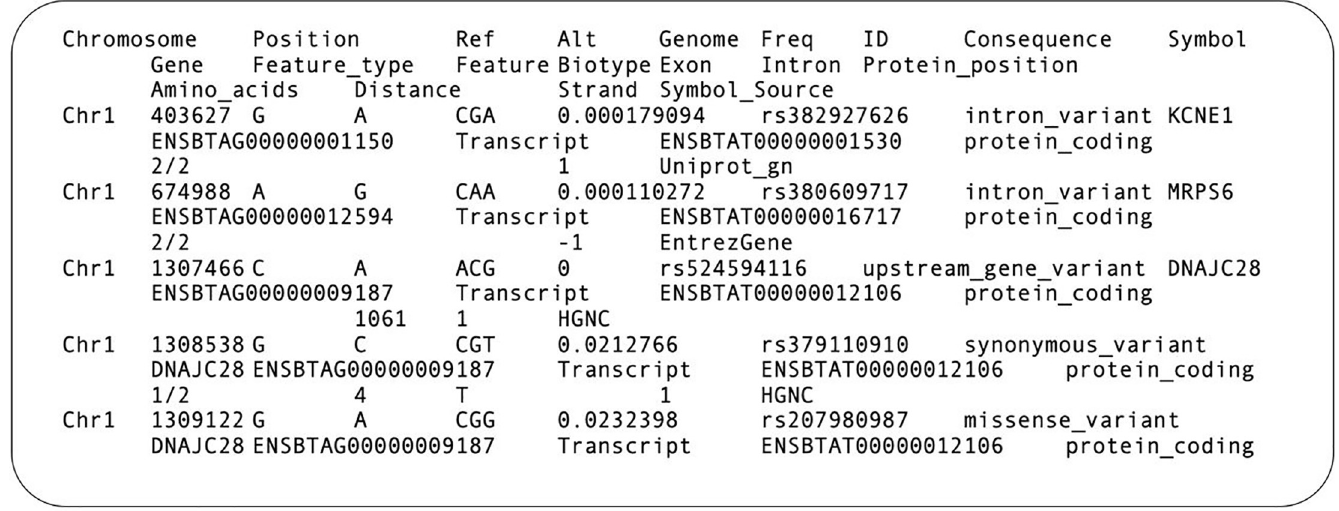
Fig 3. Example of meSNP database conformation, developed from the annotations contained in Run5 of the 1000 Bull Genomes Project and the Variant Effect Predictor. In the "Genome" column the second nucleotide represents the position of the meSNP in reference genome UMD3.1.1, described in the "Position" column; this nucleotide is also described in the "Ref" column. The "Alt" column represents the change caused by meSNP in the genomic sequence.